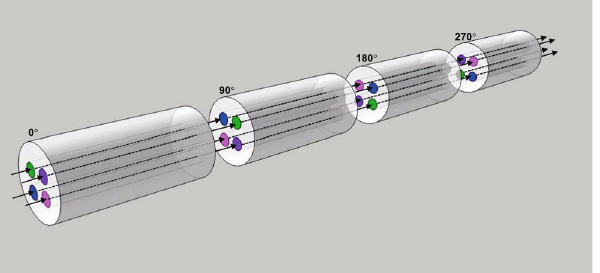
Figure 6. Compensation of the decoherence due to group delay mismatch between the cores. Four equal-length fibres are spliced such that cores 1, 2, 3 and 4 are respectively coupled to cores 2, 3, 4 and 1 at the three splice points. The numbers are the relative azimuthal angles of the